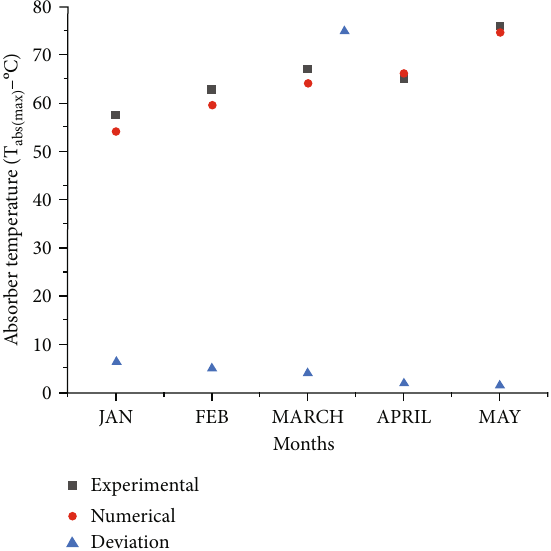
Figure 20: Changes in experimental and numerical values of thermal e ffi ciency with volumetric fl ow